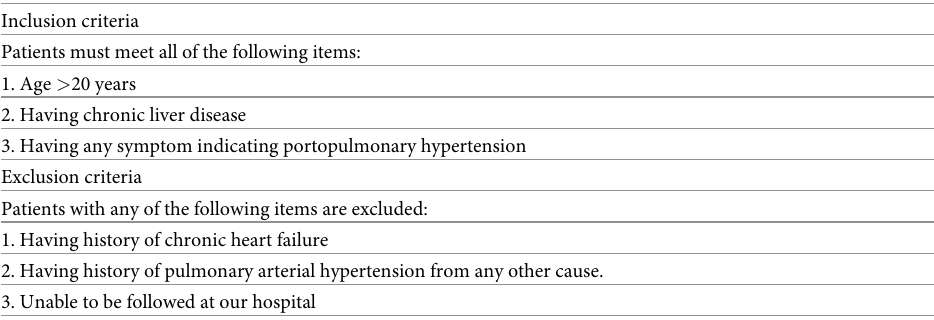
Table 1. Inclusion and exclusion